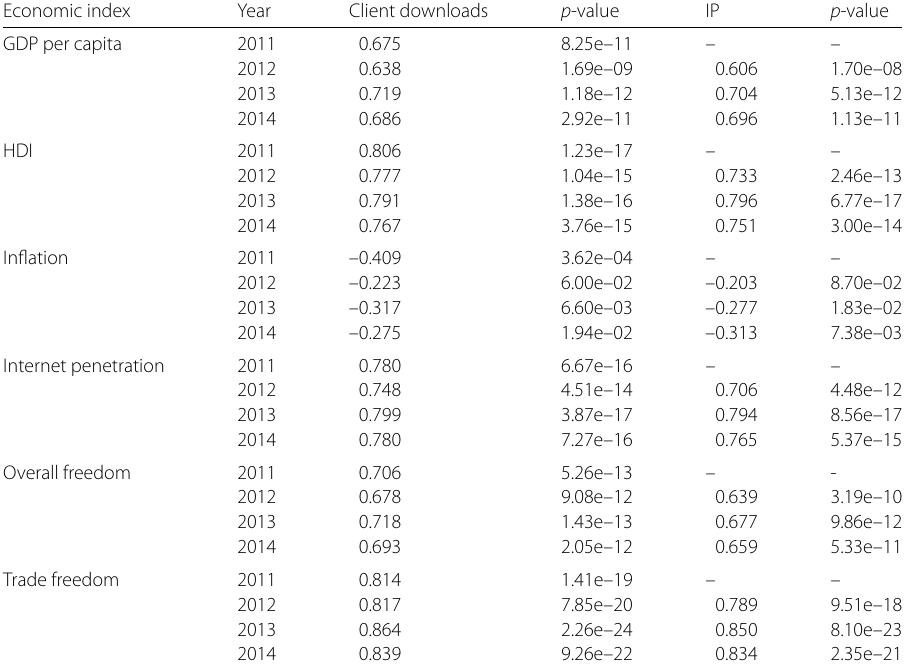
Table 6 Spearman correlations between the ranks of countries obtained using the number of unique IP addresses and each socio-economic index collected, and the ranks obtained using the number of Bitcoin client downloads and each socio economic index